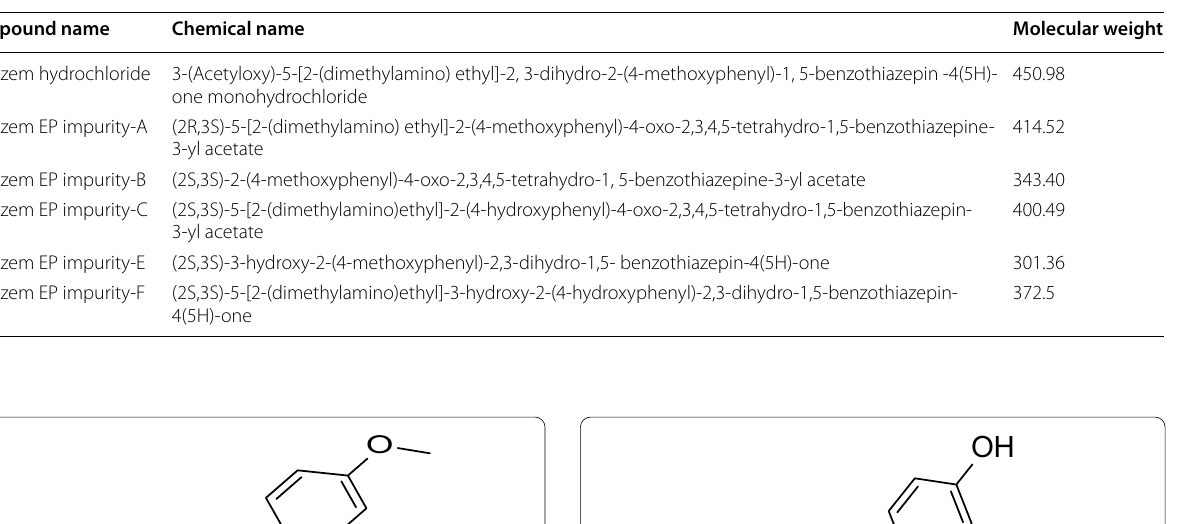
Table 1 Chemical name of Diltiazem and its impurities